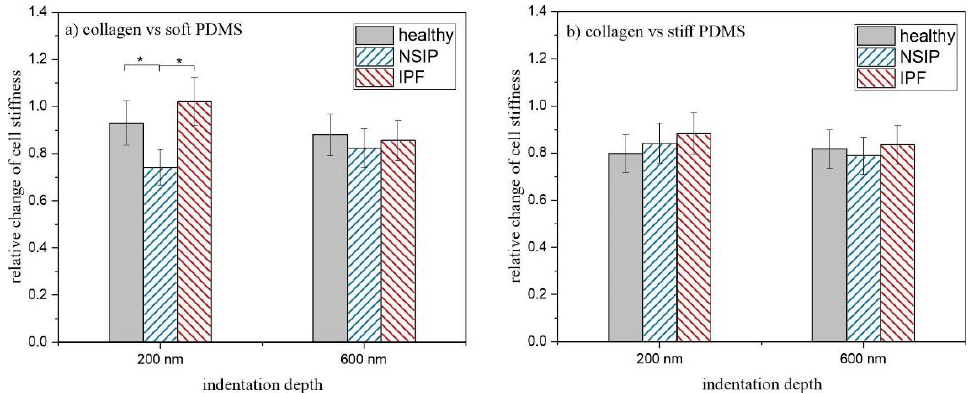
Figure 3. Relative change of cell stiffness calculated for healthy, IPF- and NSIP-derived fibroblasts cultured on ( a ) soft and ( b ) stiff PDMS substrates covered with collagen. Statistical significance marked with * was achieved for p < 0.01; error bars indicate the SD ( n ≥ 100).